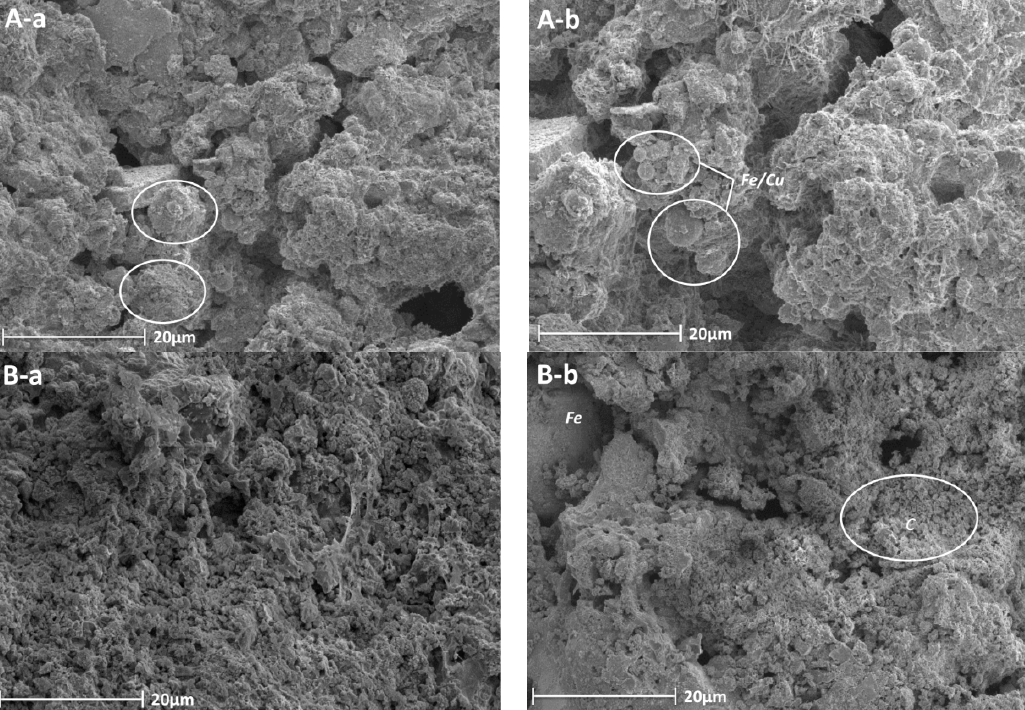
Figure 6. The surface appearance of CCF and CF (( A )-CCF, ( B )-CF; ( a )-after applied, ( b )-before applied).